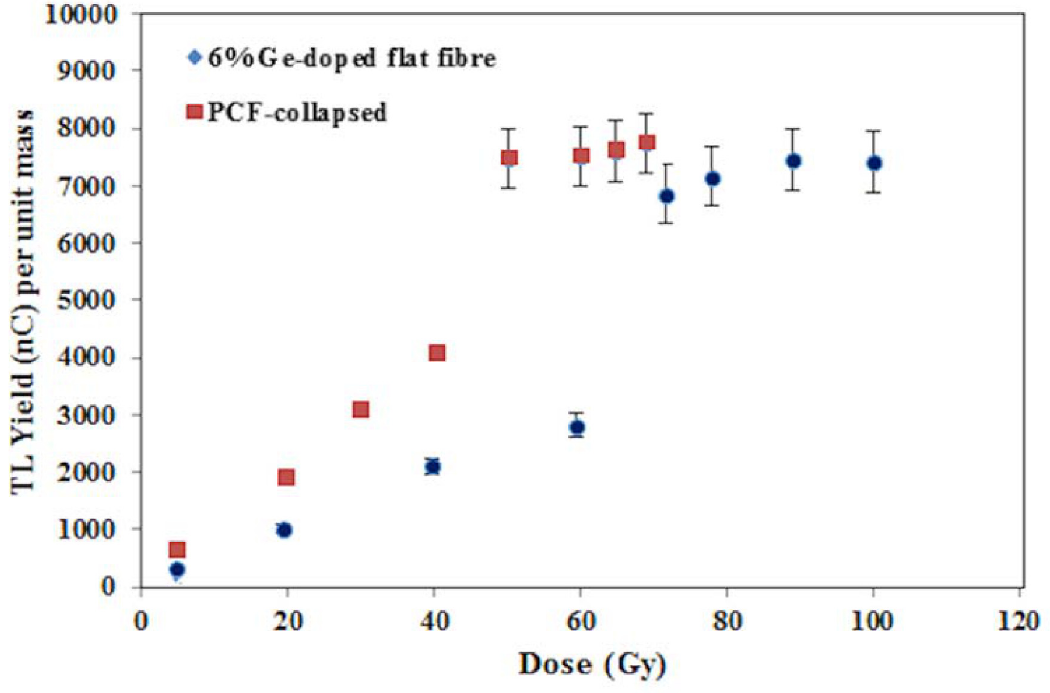
Fig 8. TL response of the 6% Ge-doped flat fibre and PCF-collapsed for high dose range. The fig compares the response of of the 6% Ge-doped flat fibre and PCF-collapsed for high dose range.